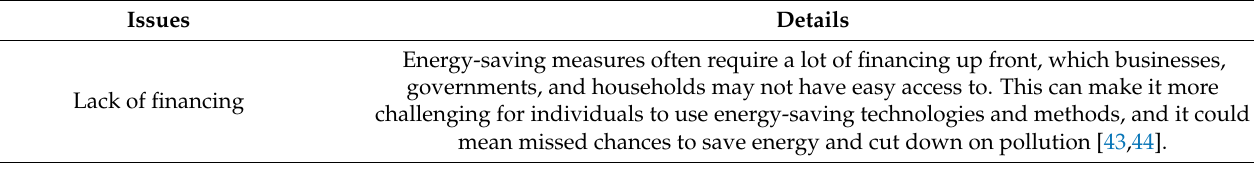
Table 1. Issues in energy